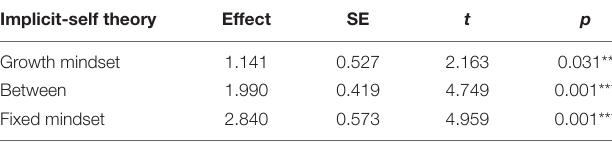
TABLE 1 | Demographic information.